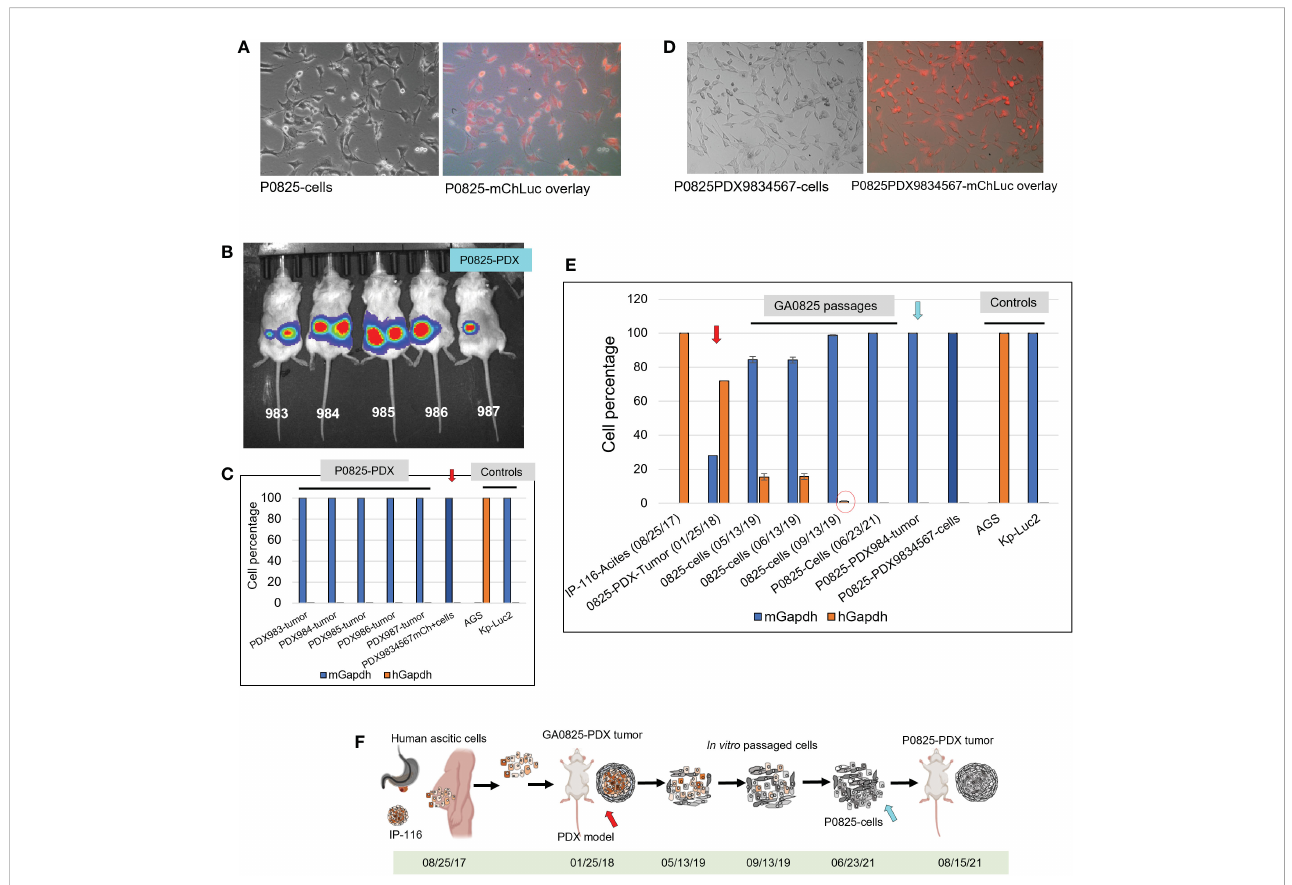
FIGURE 4 Murine P0825 cells injected into mice to generate PDX models and time progression of human-to-mouse transition and oncogenic transformation. (A) P0825 was labeled with lentiviral mCherry (mChLuc), micrographs showed in bright fi eld and mCherry overlay. (B) P0825 cells were injected subcutaneously into fi ve mice to generate PDX models, with luciferase imaging for the mice. (C) Intronic qPCR quanti fi cation of the PDX tumors from the fi ve mice, with the arrow pointing to the merged cell pool derived from tumors of the fi ve PDX mice. AGS and Kp-Luc2 served as controls for qPCR. (D) The merged cell pool P0825PDX9834567 derived from the fi ve PDX tumors from B showed micrographs in bright fi eld and mCherry overlay. (E) Time progression of GA082516-PDX-G1 (with red arrow), its ancestral patient ascites IP-116 and its derived cell pools, intronic qPCR quanti fi ed the human-to- mouse transition from patient IP-116 to murine PDX-derived cells over time, showing human percentages decremental and murine percentages incremental. P0825 (06/23/2021) and P0825PDX9834567 cells (with blue arrow) are determined as fully murine cells. (F) An illustration depicting time progression of this human-to-mouse transition re fl ected in E (red and blue arrows matching F with